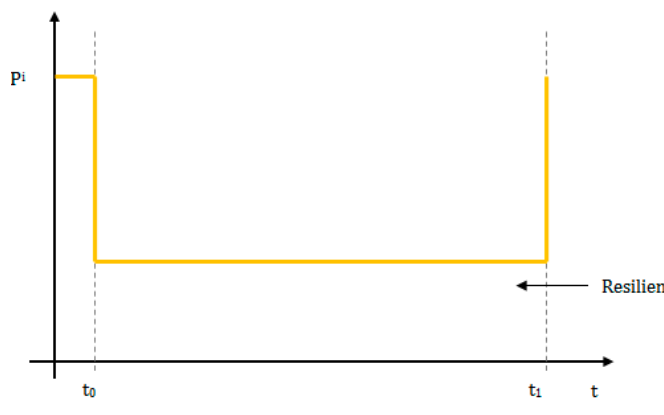
Figure 3. Sample of a static performance measure—Option 1.